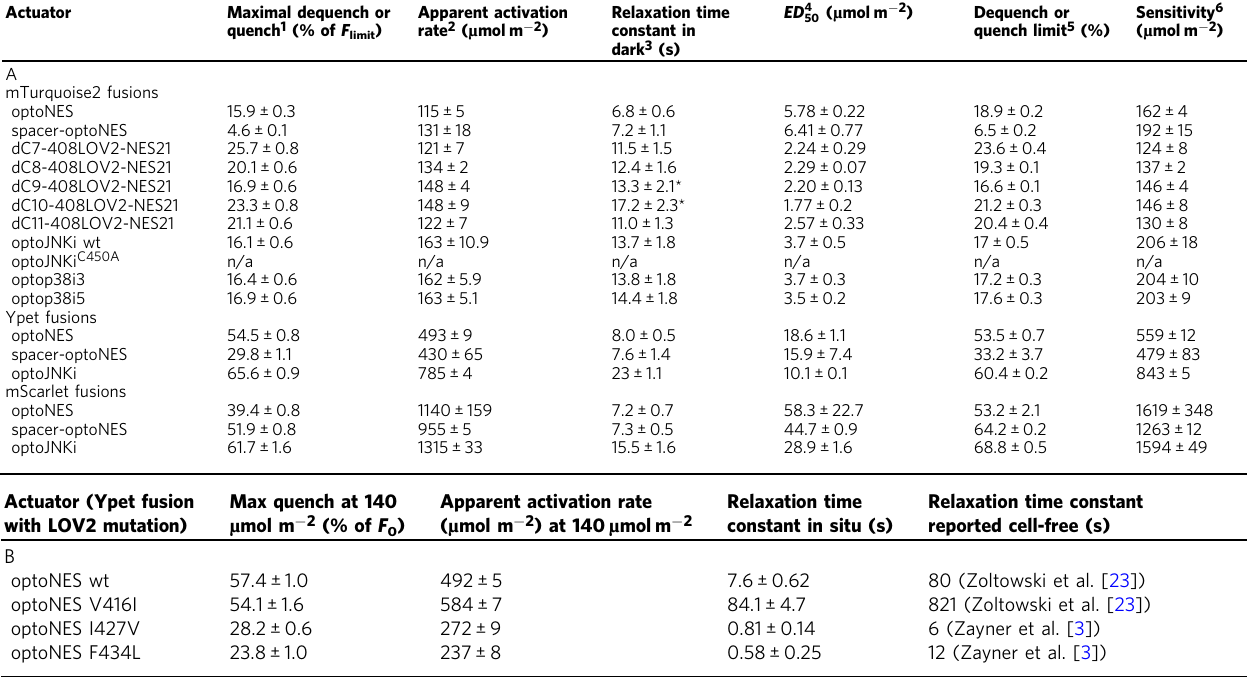
Table 1 Properties of constructs examined in this study determined by resonance energy transfer.